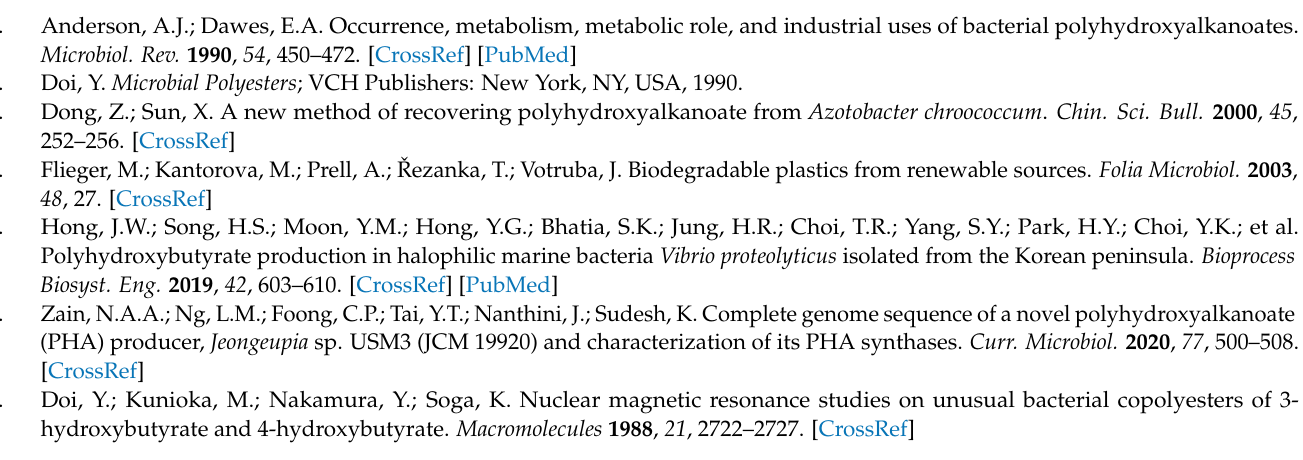
A. vinelandii ∆ Avin_16040 mutant strain. Figure S2: 1 H NMR spectrum of P(3HB- co -10 mol% 4HB) produced by A . vinelandii ∆ Avin_16040 . Table S1. Biosynthesis of P(3HB) by A . vinelandii ∆ Avin_16040 mutant strain, C . necator PHB¯4, and C . necator Re2058 harbouring phaC of A . vinelandii mutant cell using different concentrations of